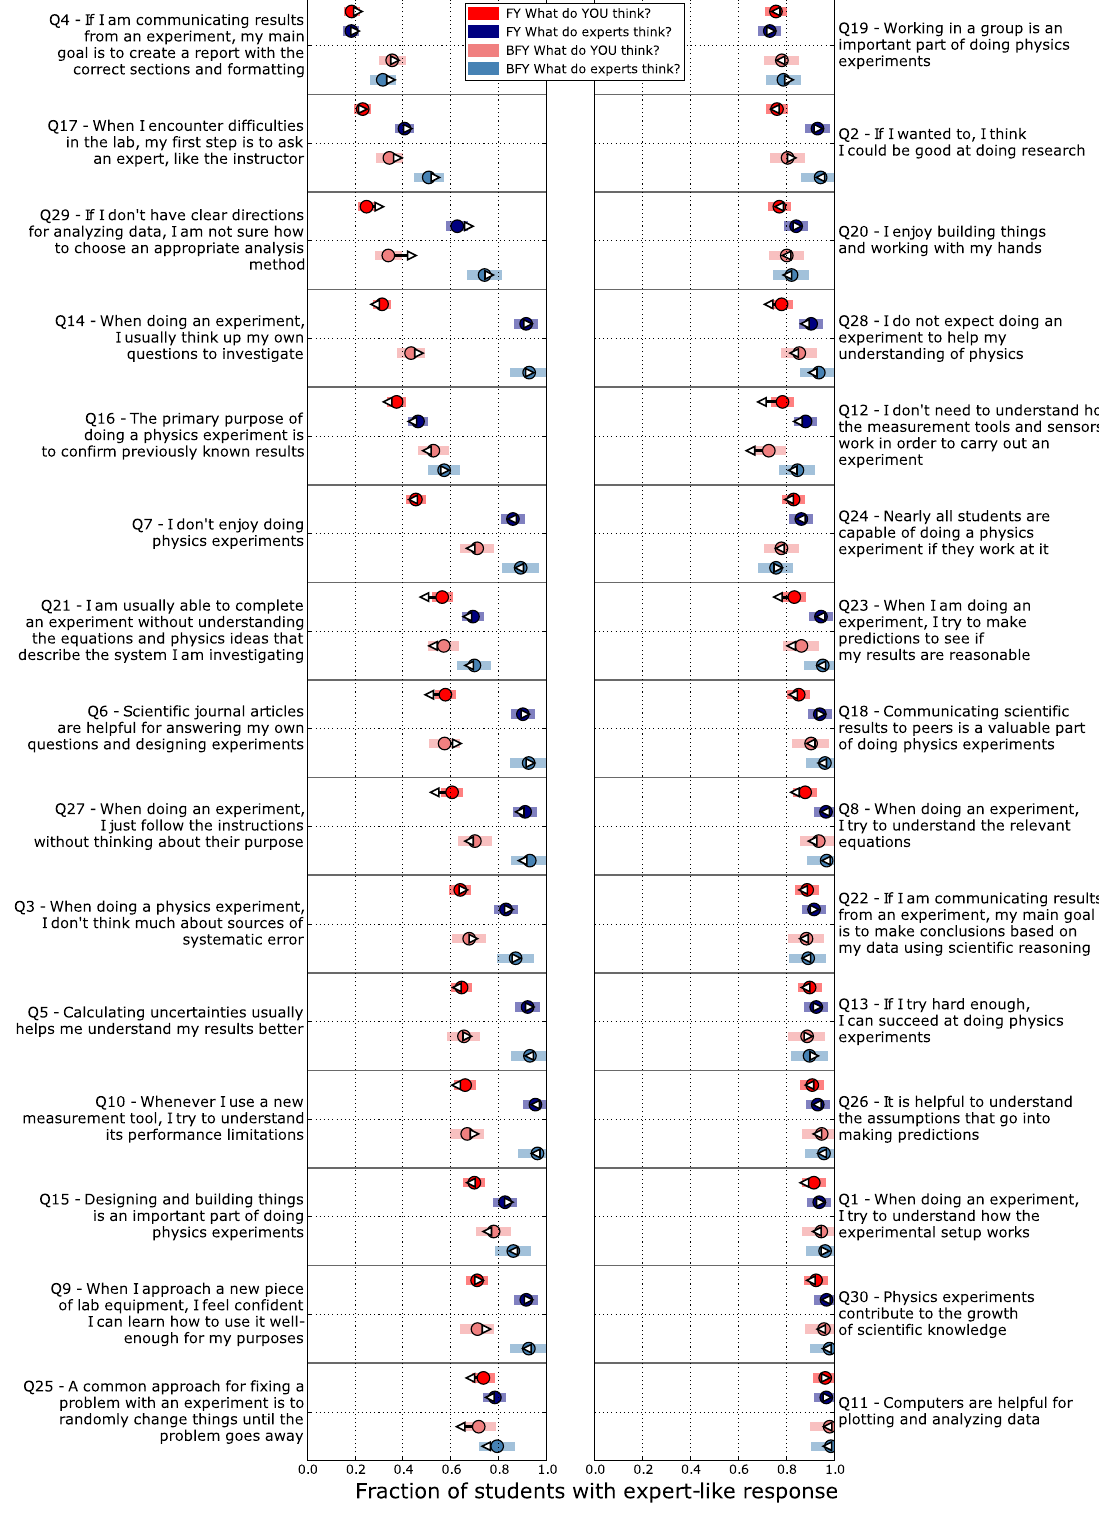
FIG. 2. Fraction of students with expertlike responses for each E-CLASS item. Items are ordered by fraction favorable among FY students. Solid circles indicate the preinstruction fraction while the arrow indicates the postinstruction fraction and points in the direction of the shift from pre- to postinstruction. Shaded bars indicate the 95% confidence interval on the preinstruction fraction. Red and pink represent students ’ responses from their own perspective for FY and BFY students, respectively, and blue and teal points represent students ’ predictions of what an experimental physicist might say for FY and BFY students,